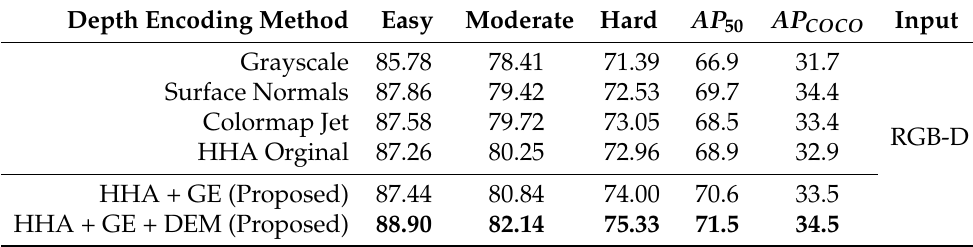
Table 4. Comparison of depth encoding methods on the KITTI val dataset for RGB-D pedestrian